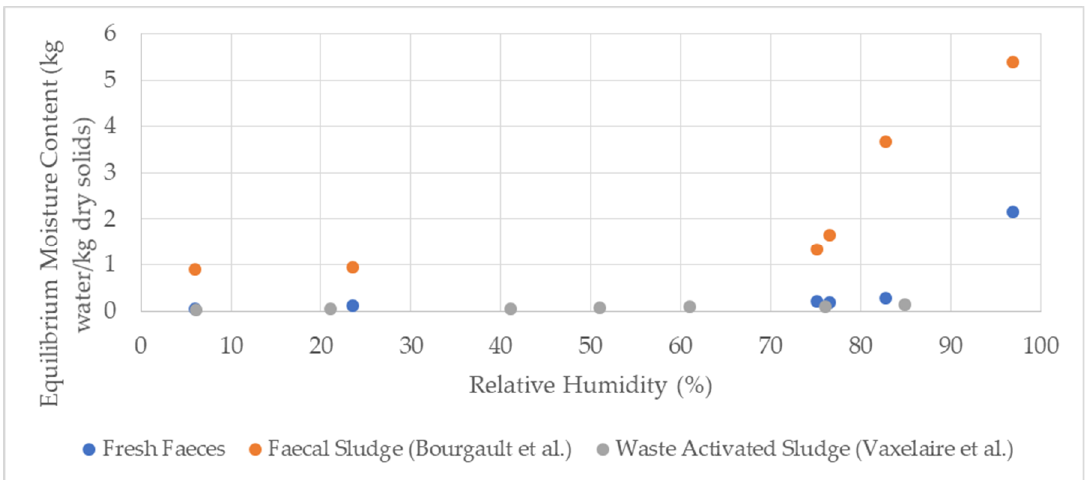
Figure 5. Comparison of equilibrium moisture content of fresh feces at 35 °C (measured in the present analysis), fecal sludge 35 °C [21], and waste activated sludge at 39 °C [8].